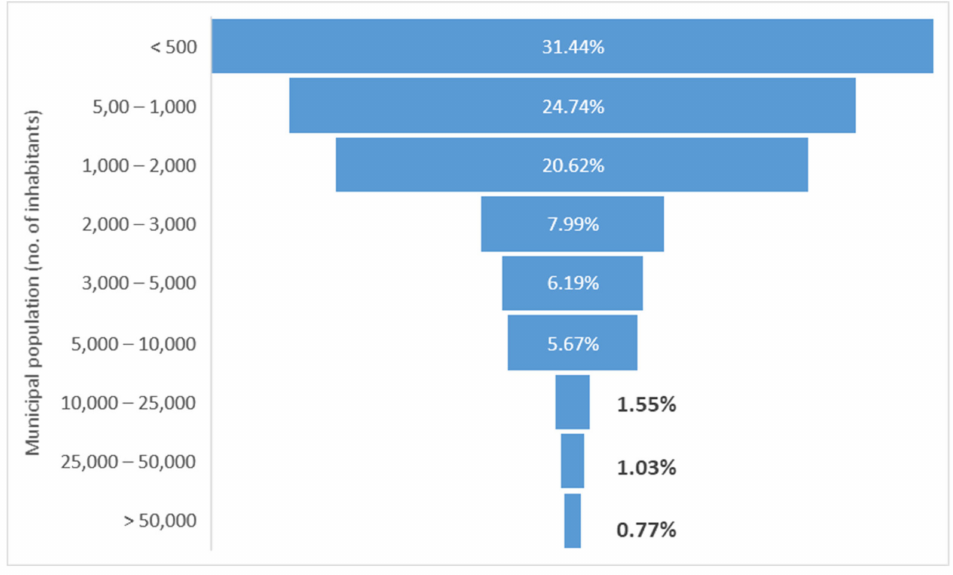
Figure 2. Distribution of municipalities by population in Extremadura (Spain) [50].